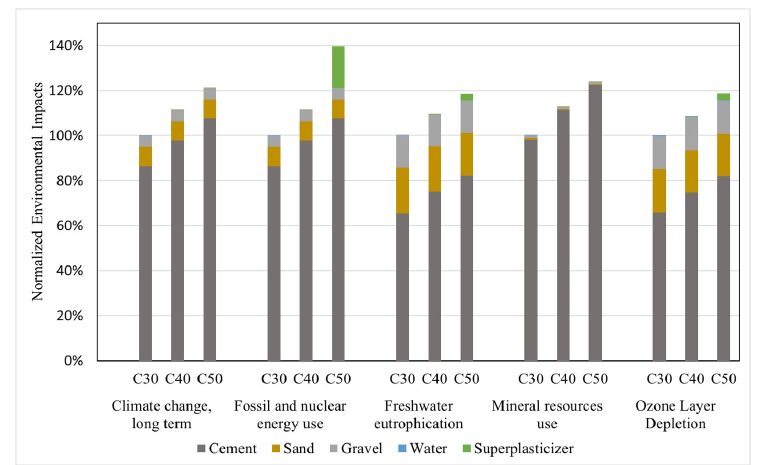
Figure 4. Impacts 1 m 3 of concrete detailed by the